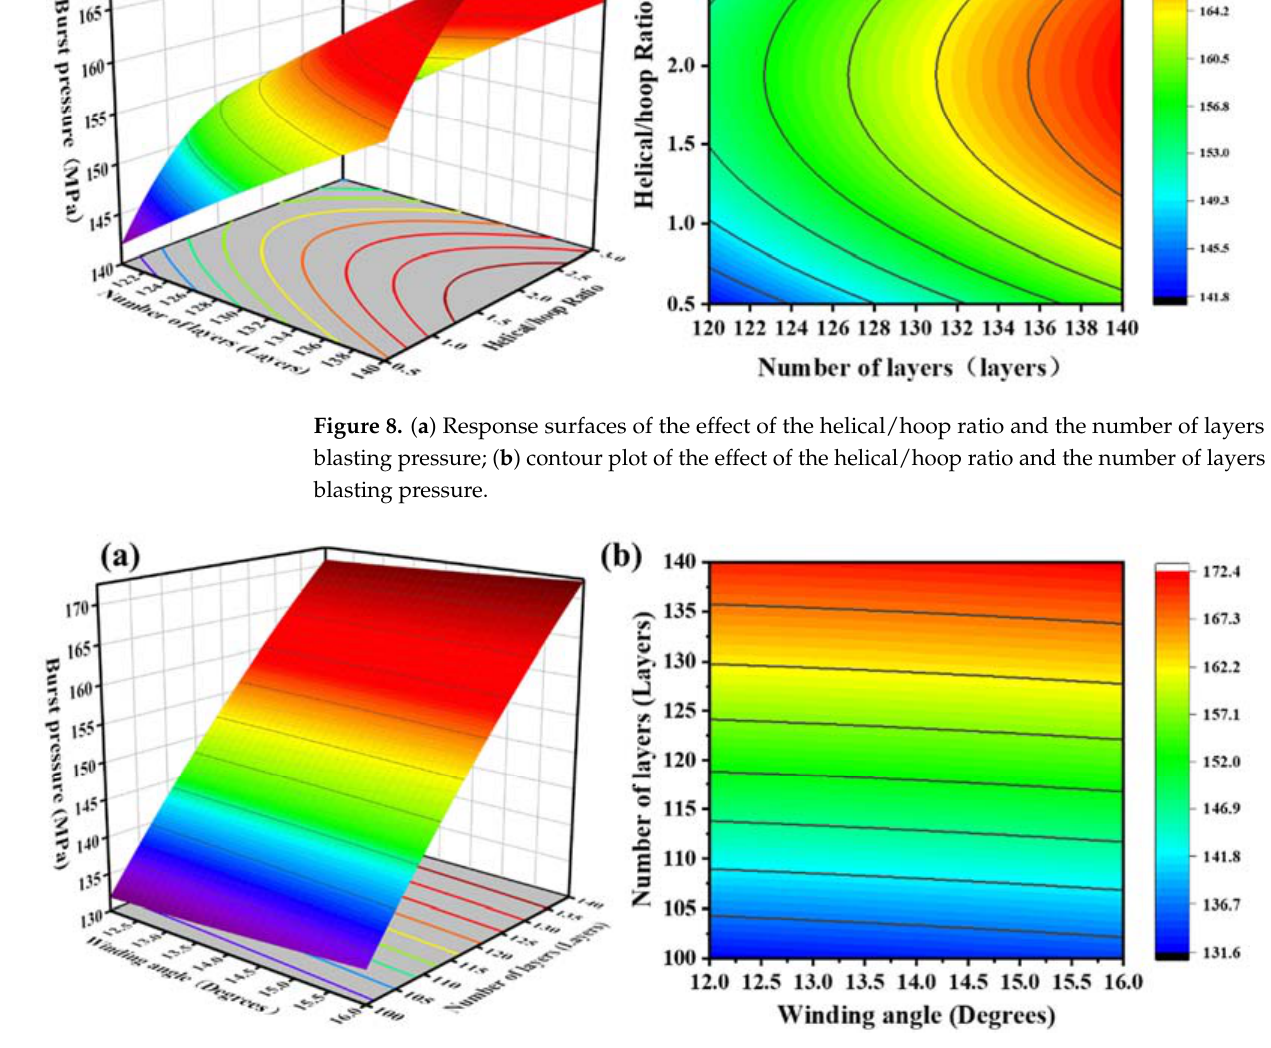
Figure 9. ( a ) Response surfaces of the effect of the winding angle and the number of layers on the blasting pressure; ( b ) contour plot of the effect of the winding angle and the number of layers on blasting pressure.